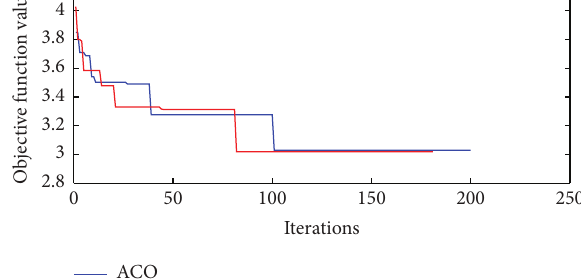
Figure 3: Trends of objective function value.